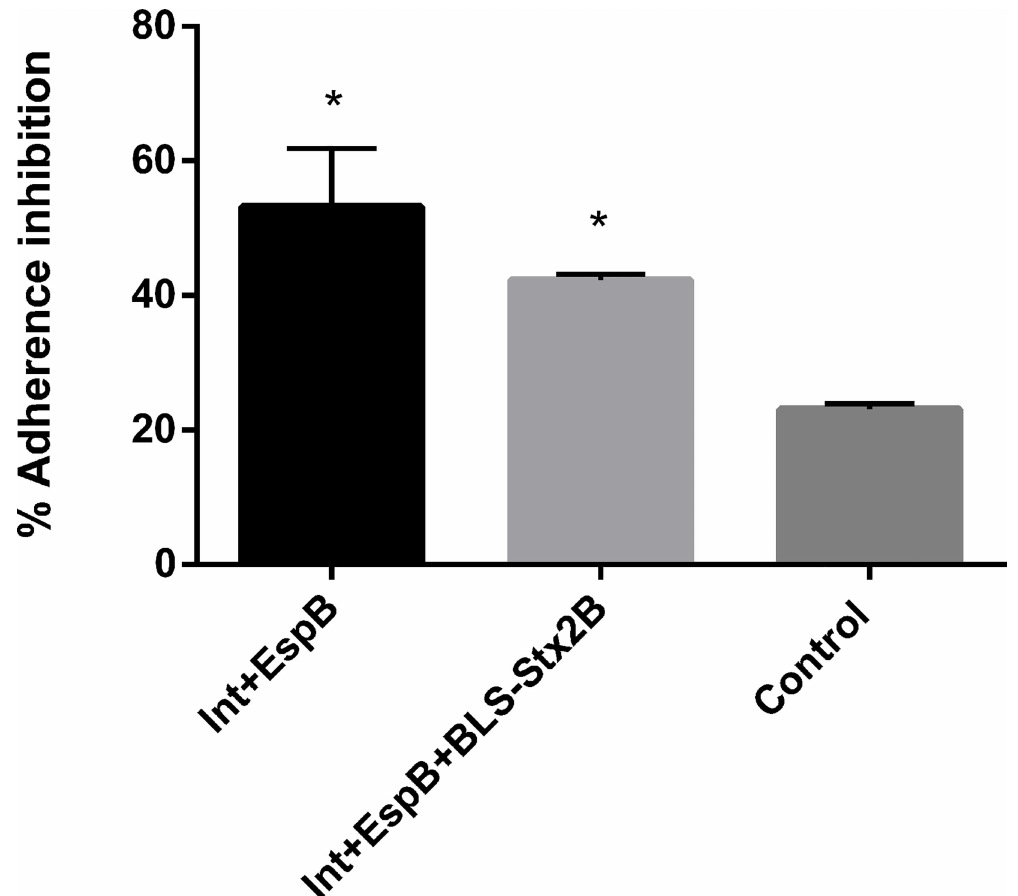
Fig 5. Inhibition of E. coli O157:H7 adherence to Hep-2 cells by sera from calves vaccinatedwith IntiminC 280 + EspB + BLS-Stx2B (3Ag); IntiminC 280 + EspB (2Ag); and PBS (control). Results are represented as % of inhibitionof adherencerespect to strain EHEC 438/99 without sera. Data are shown as mean ± standard error of the mean of 3 experiments performed ( * P < 0.05). * Indicates statistical significance comparedto the control (p <